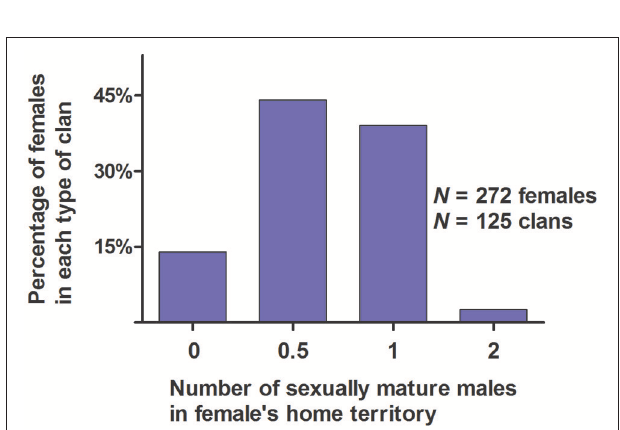
FIGURE 5 | Percentage of females in the different types of clans of white-tailed prairie dogs at the Arapaho National Wildlife Refuge, Colorado USA, in June of each year from 2006 through 2012. These data are only from clans with ≥ 1 female (i.e., we have not included solitary males). “0” on the X-axis is for territories that did not have a resident sexually mature male. “0.5” on the X-axis is for “half-male” territories in which a male spent some of his time; he spent the rest of his time in a different territory with a different group of